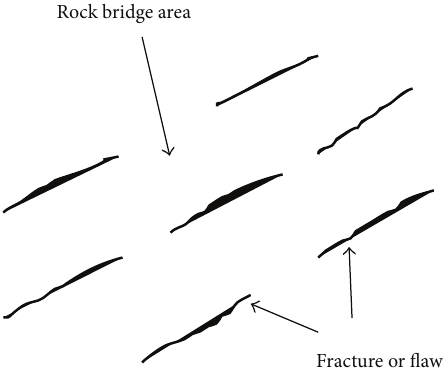
Figure 1: Rock bridge area in discontinuous